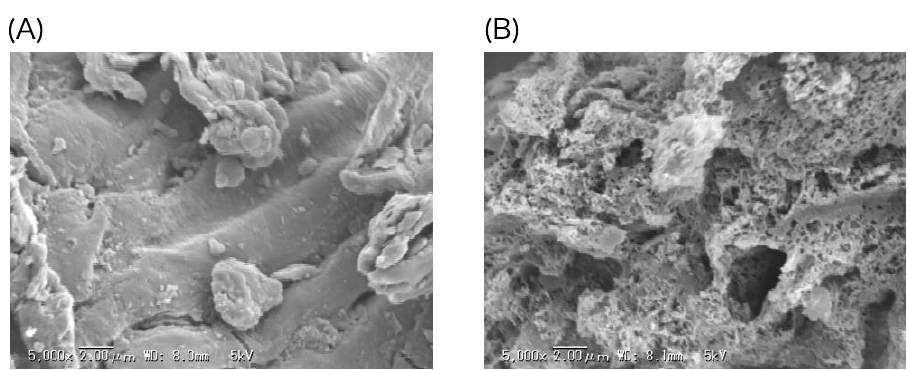
Figure 5. SEM images of unactivated adsorbent ( A ) and K 2 CO 3 -activated adsorbent ( B ). The amount of adsorbed iodine is listed in Table 1. This measurement method is based on a modified Japanese industrial standard [20]. The approximate specific surface area of a sample can be calculated from the amount of adsorbed I 2 ; the surface area occupied by an I 2 molecule is 0.40 nm 2 . Assuming that I 2 covers the adsorbent surface to form a molecular monolayer, the approximate specific surface area, SSA (m 2 /g), is given by Equation (1). Here, n is the amount (number) of the adsorbed I 2 molecules and w (g) is the weight of the sample adsorbent.